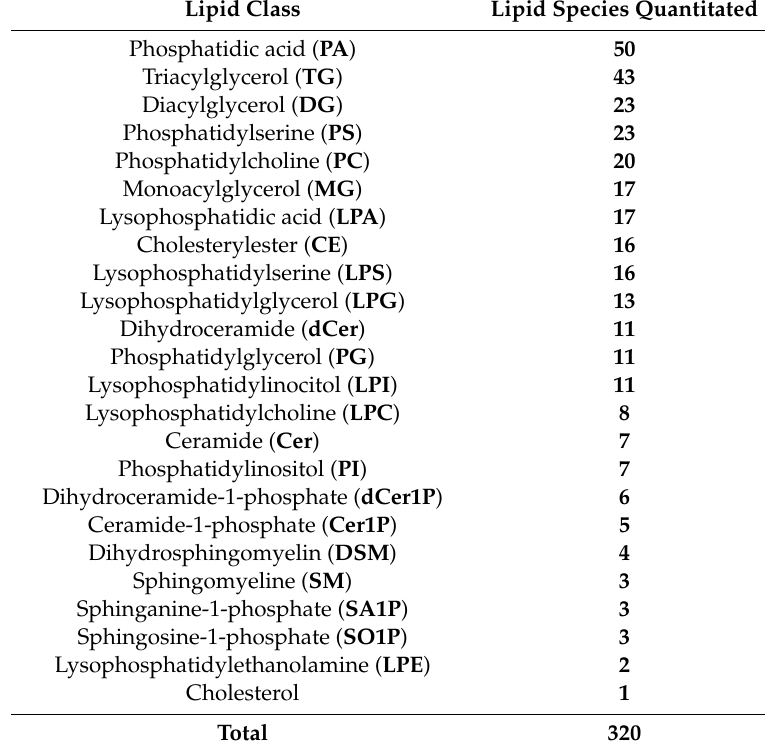
Figure 2. The discriminative lipidomic profile of L. plantarum -derived extracellular vesicles. Principal component analysis (PCA) of lipidomic information was performed based on the mass spectrometry (MS) data of LEVs and L. plantarum . Lipidomic data were analyzed statically using the package in MetaboAnalyst ( n = 9 per group; three independent biological replicates and three technical replicates). X axis: principal component 1 (PC1). Y axis: principal component 2 (PC2), Z axis: principal component 3 (PC3). Table 1. The detected lipid classes by LC-MS from both LEVs and L. plantarum . The number of identified lipid species in each lipid class was shown in descending order.